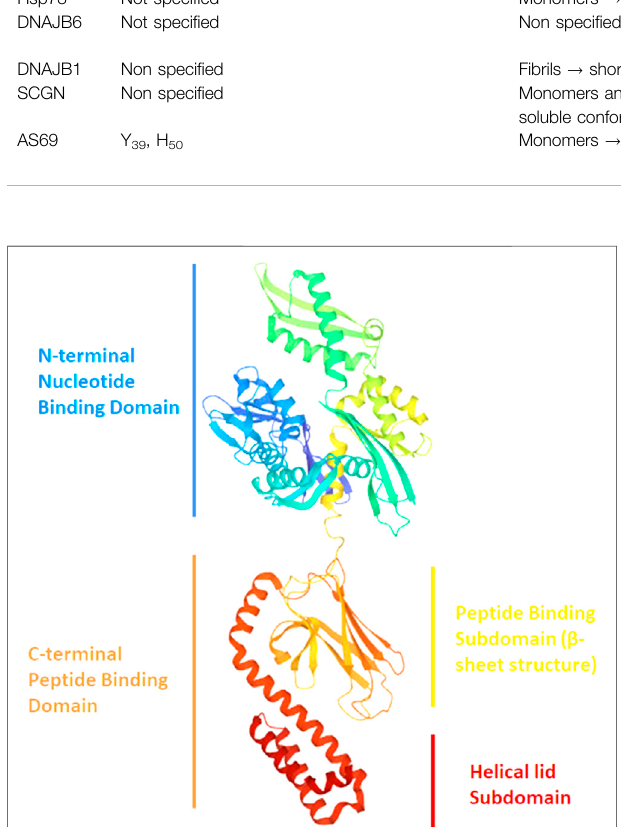
FIGURE 8 | Ribbon drawing illustrating the structure of Hsp70 with its different domains (PDB fi le 2KHO).